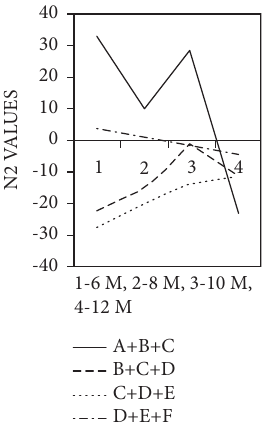
Figure 10: N2 values with increasing molarity of alkaline solution (28 days’ curing).